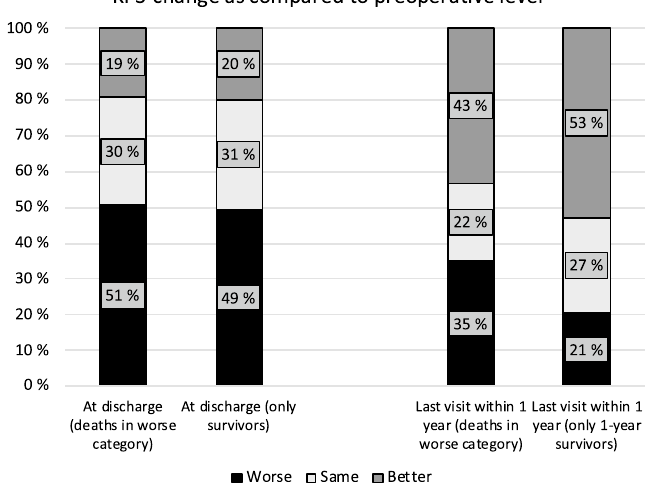
Figure 3. Comparison between pre- and postoperative performance levels (measured by KPS) at discharge and at the last follow-up visit within the first postoperative year.